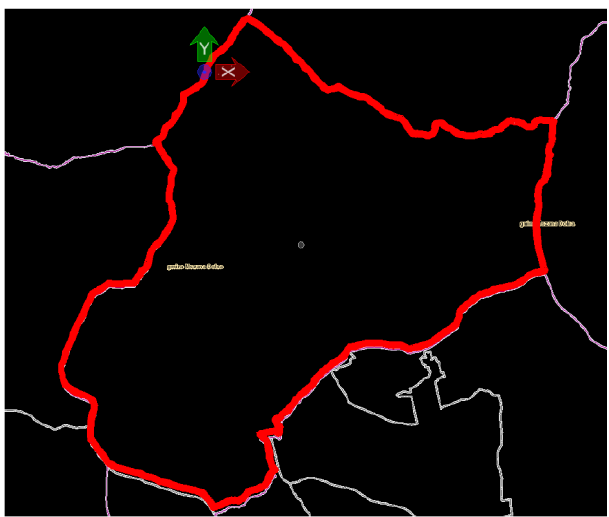
Figure 11. The approximate border of Kasinka Mala .